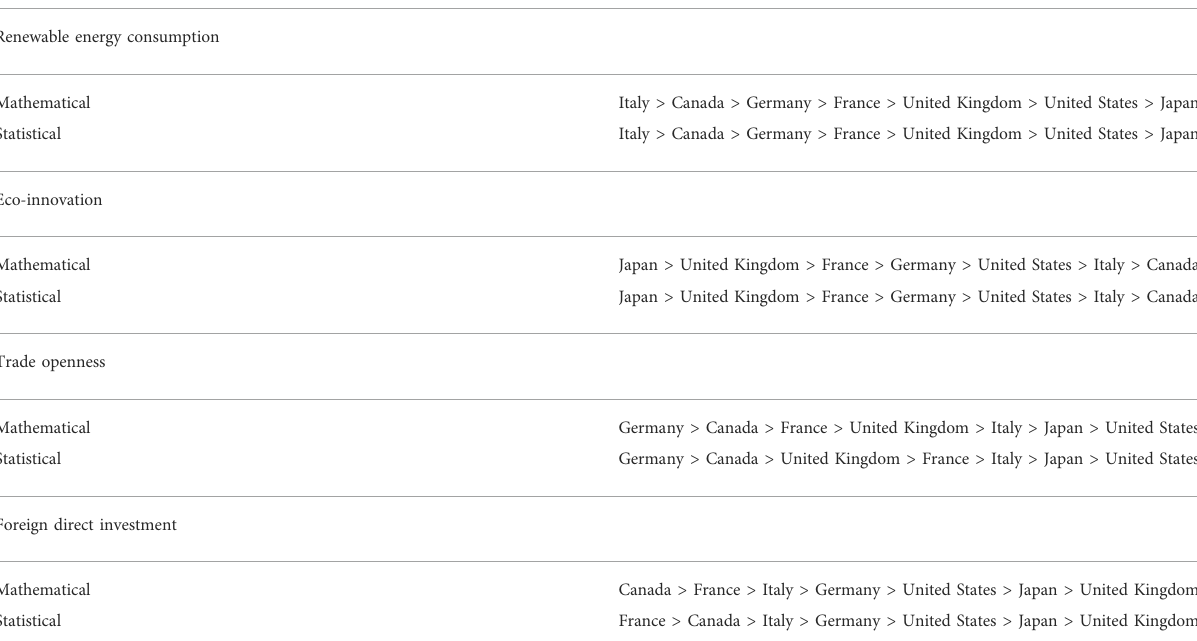
TABLE 6 Ranking sequence based on mathematical and statistical analysis. CO 2 emissions (response variable) Renewable energy